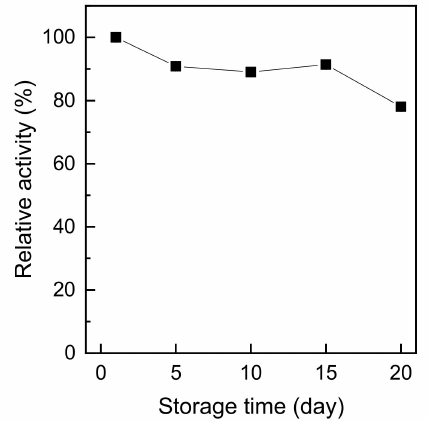
Figure 8. Storage stabilities of immobilized trypsin.